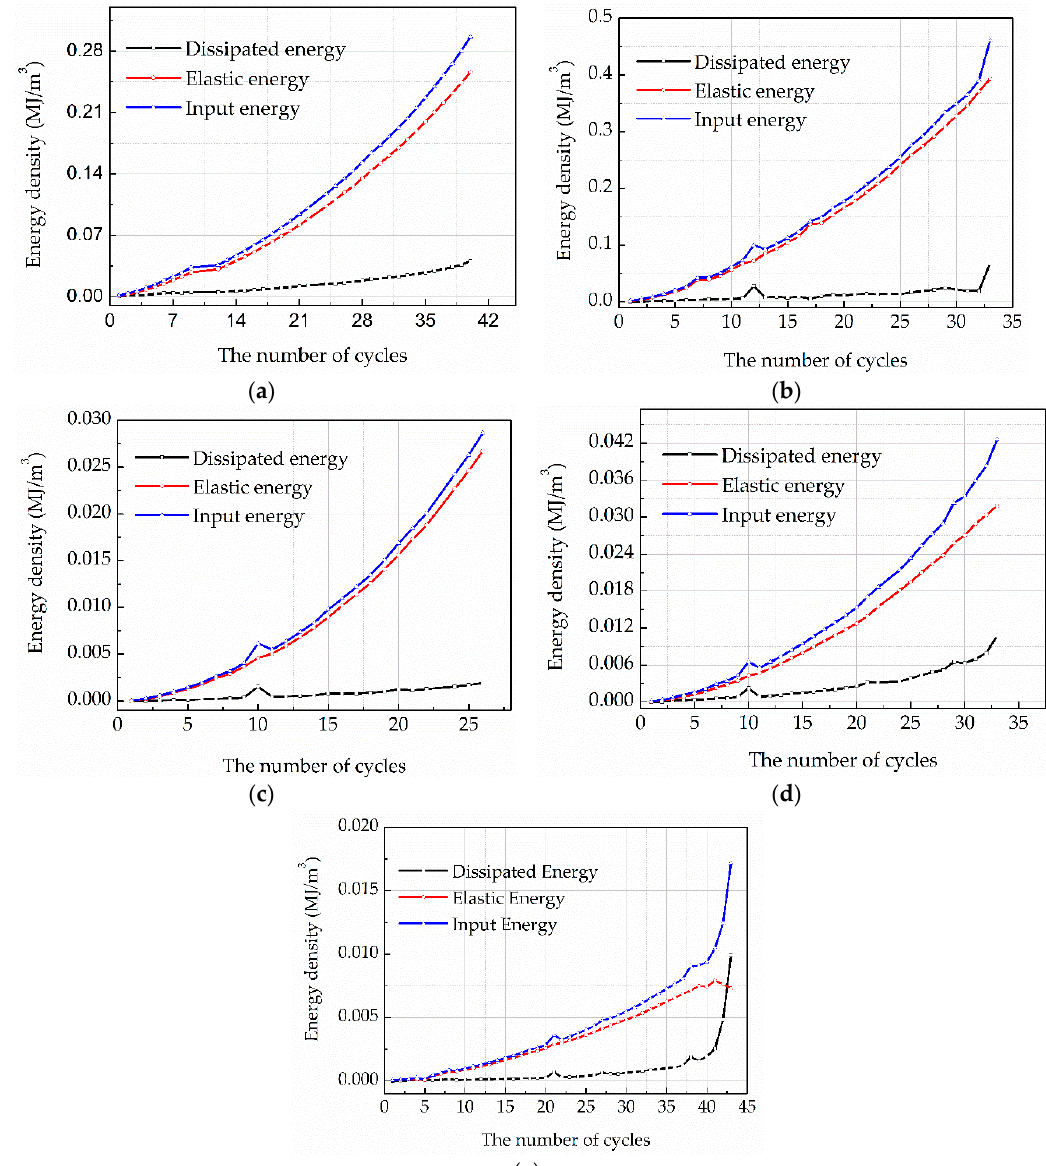
Figure 6. Energy evolution processes for different rocks. ( a ) Red sandstone, ( b ) granite, ( c ) coal, ( d ) gypsum, and ( e ) high-water material.